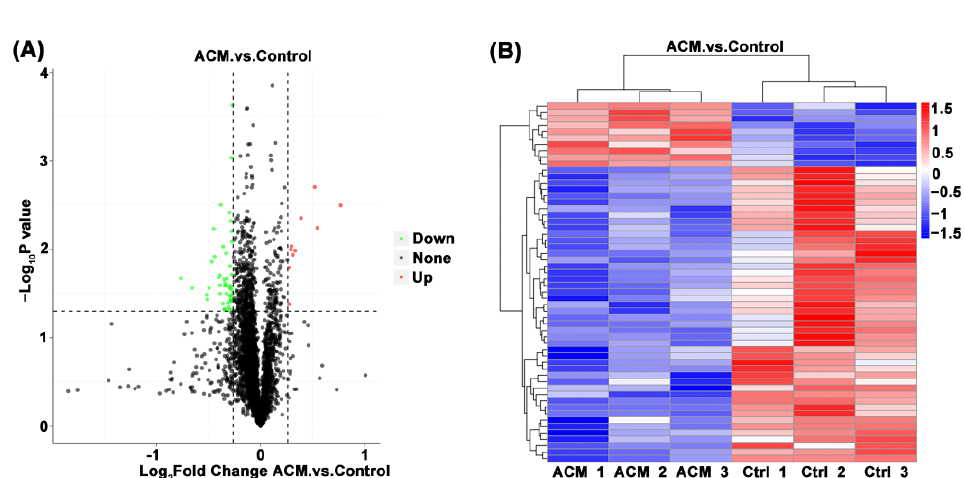
Figure 3. ( A ) Volcano plot of the myocardial proteomics data of the control group and the ACM group. DEPs are demonstrated in the volcano map. The abscissa is the logarithm of the protein difference multiple with 2 as the base, and the ordinate is the absolute value of the logarithm of the p value with 10 as the base. Black dots represent proteins that are not significantly different, and red and green represent up-regulated and down-regulated proteins, respectively. ( B ) Heat map of the differentially expressed metabolites between the control group and the ACM group. The up-regulation and down-regulation proteins among different samples are revealed by cluster analysis. Each row is adjusted for Z value, (observed value-row mean)/row standard deviation. Red and blue represent up-regulation and down-regulation, respectively.